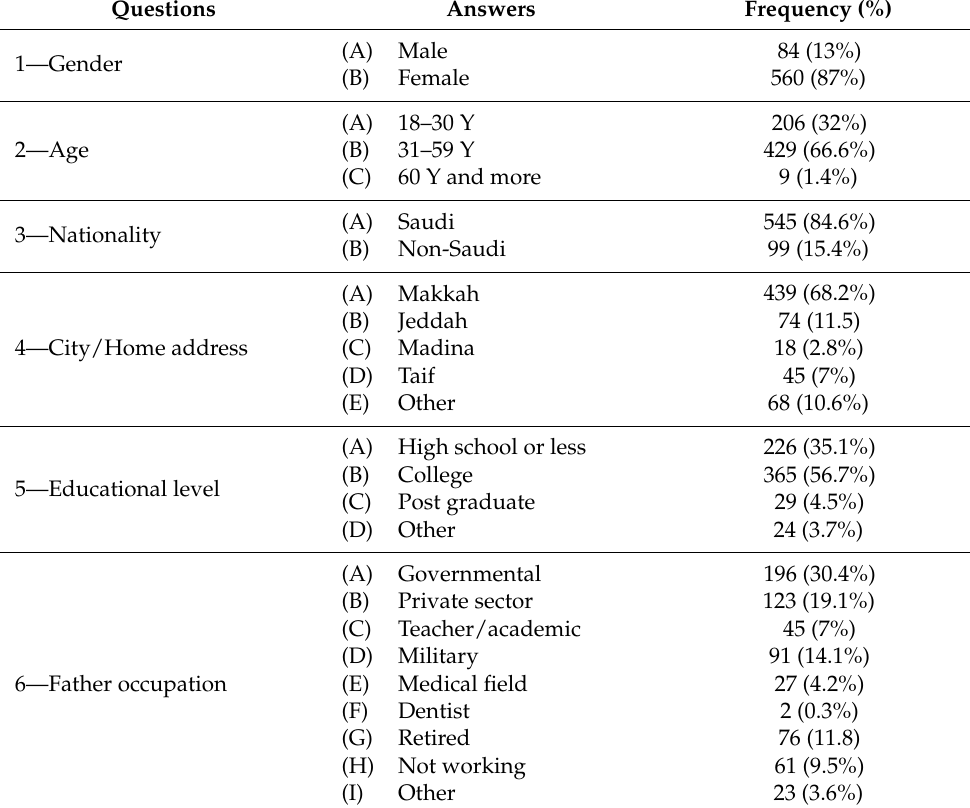
Table 1. Participants’ demographic